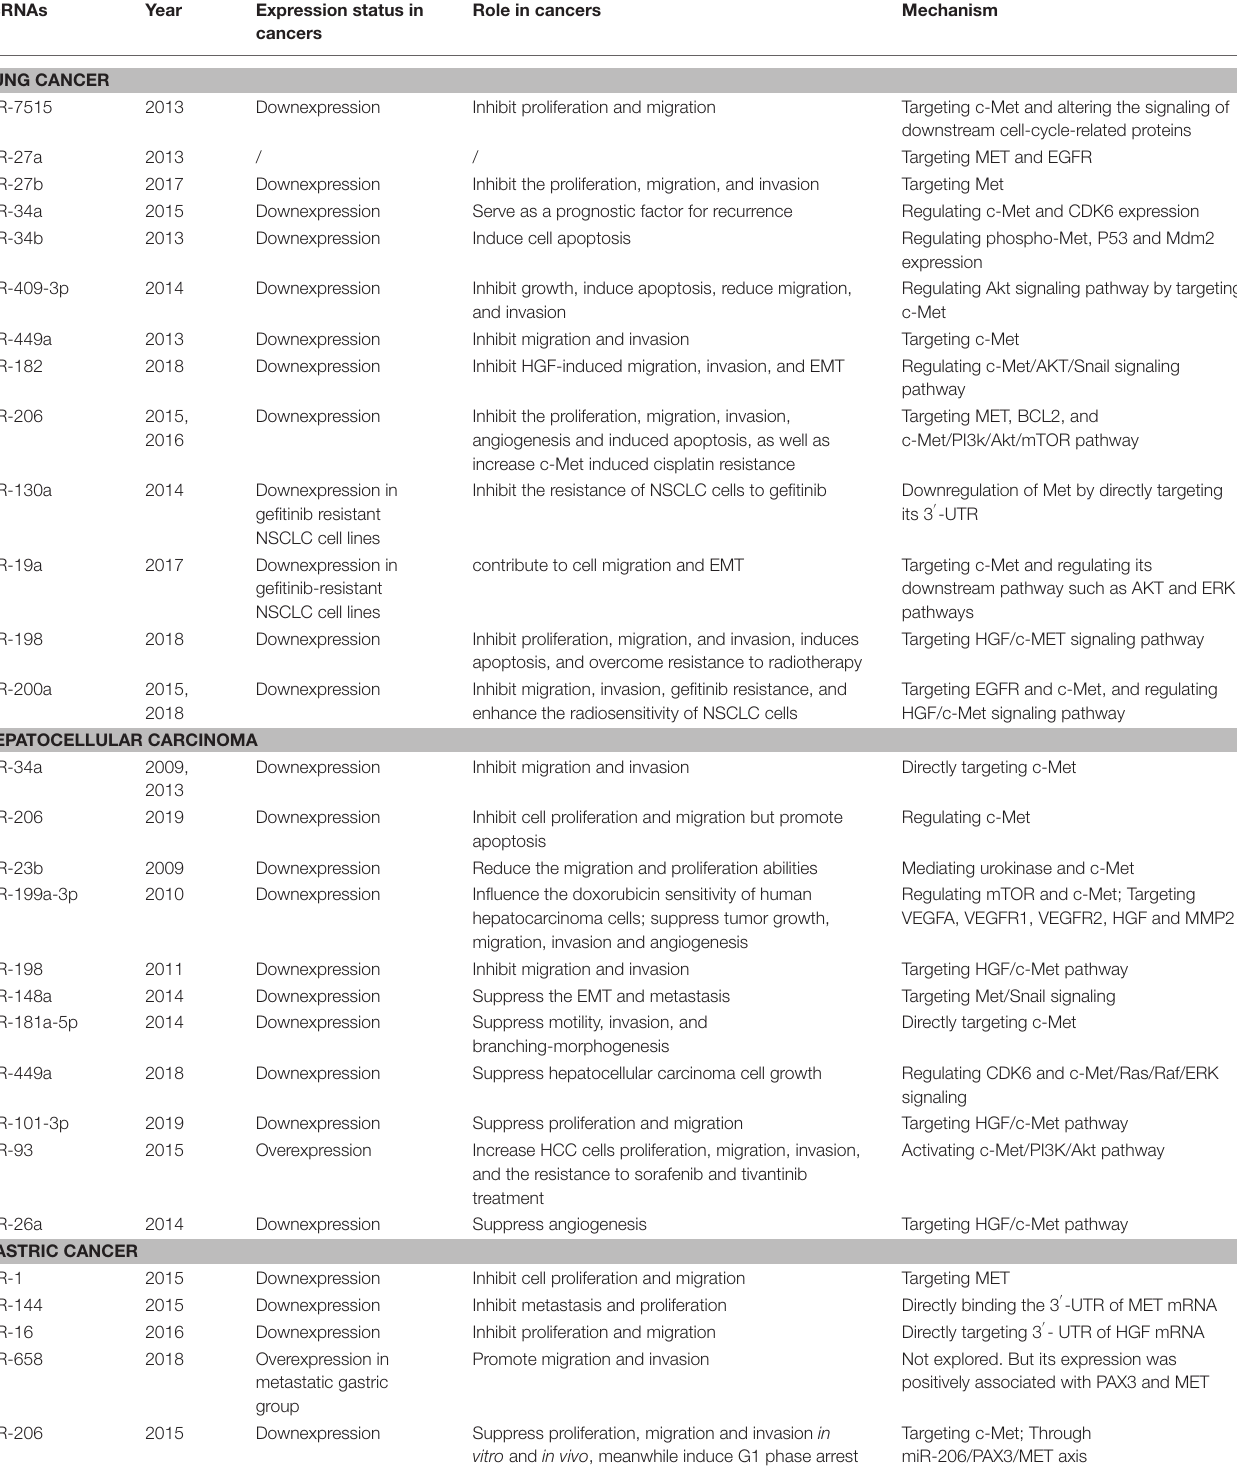
TABLE 1 | The crosstalk between microRNAs and HGF/c-Met axis in cancers.